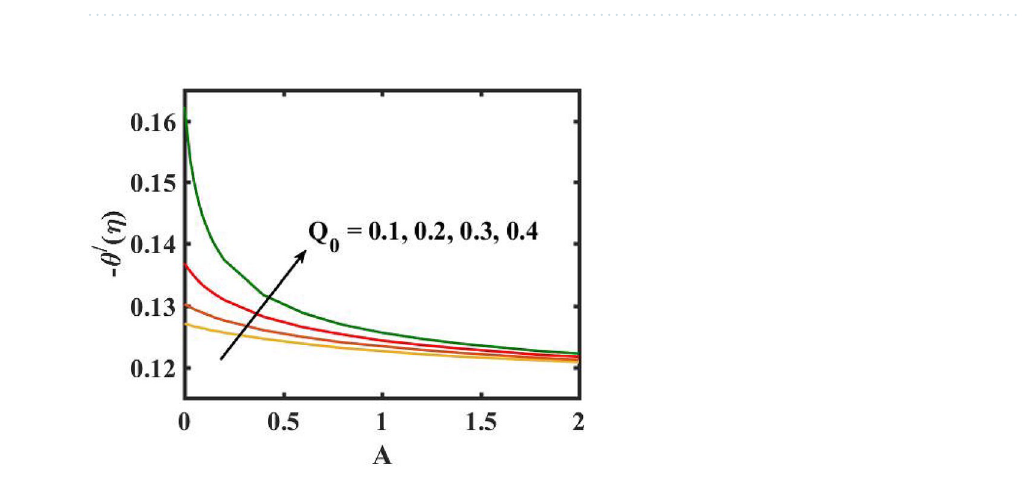
Figure 20. Encouragement of Q 0 and A on local Nusselt